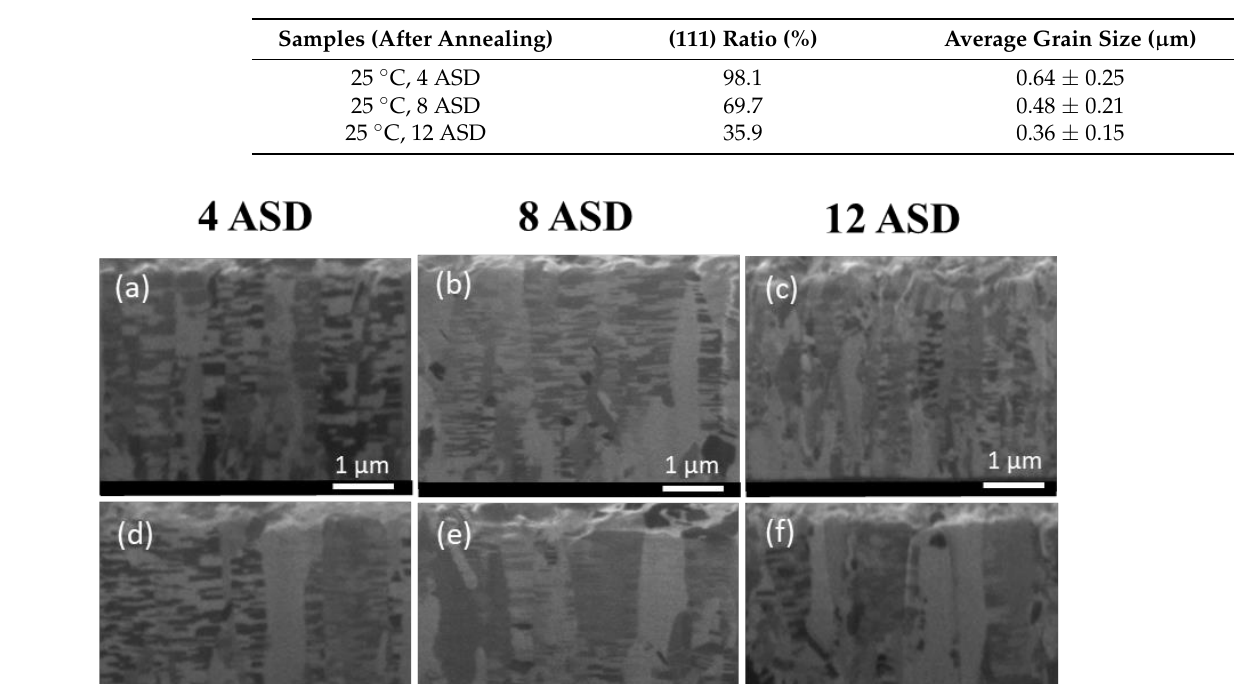
Table 2. Degree of (111) orientation and grain size of the nt-Cu films deposited at 25 °C and annealed at 200 °C for 10 h.